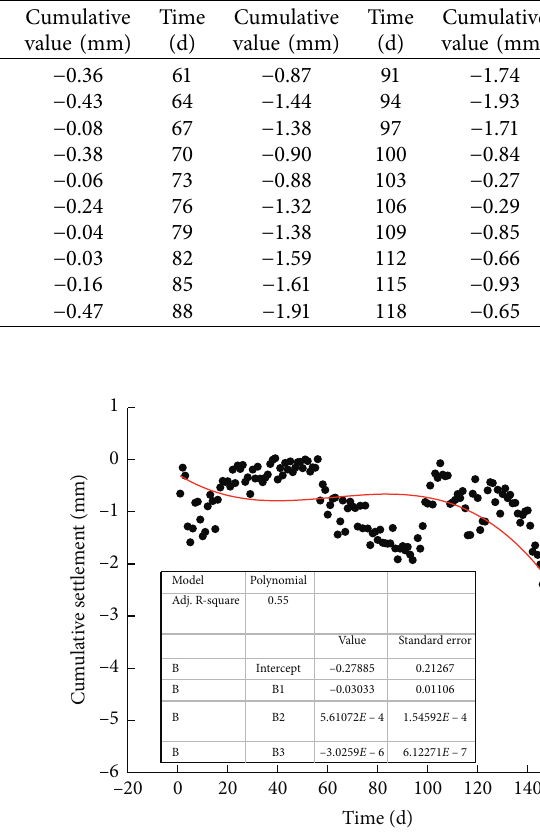
Table 6: Monitoring values at excavation stage of a measuring point of Wannianquan Road Station.